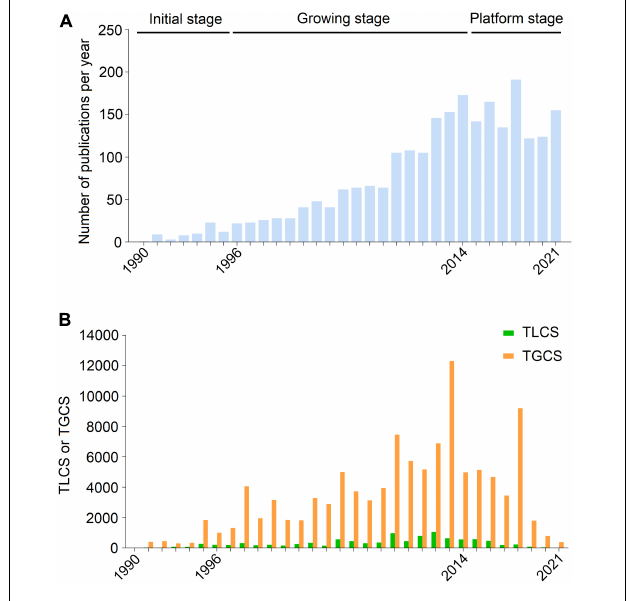
FIGURE 1 | Publication outputs and citations on uremic cardiomyopathy. (A) Global annual production trends. (B) Annual total global citation score (TGCS) and total local citation score (TLCS) of publications on uremic cardiomyopathy.